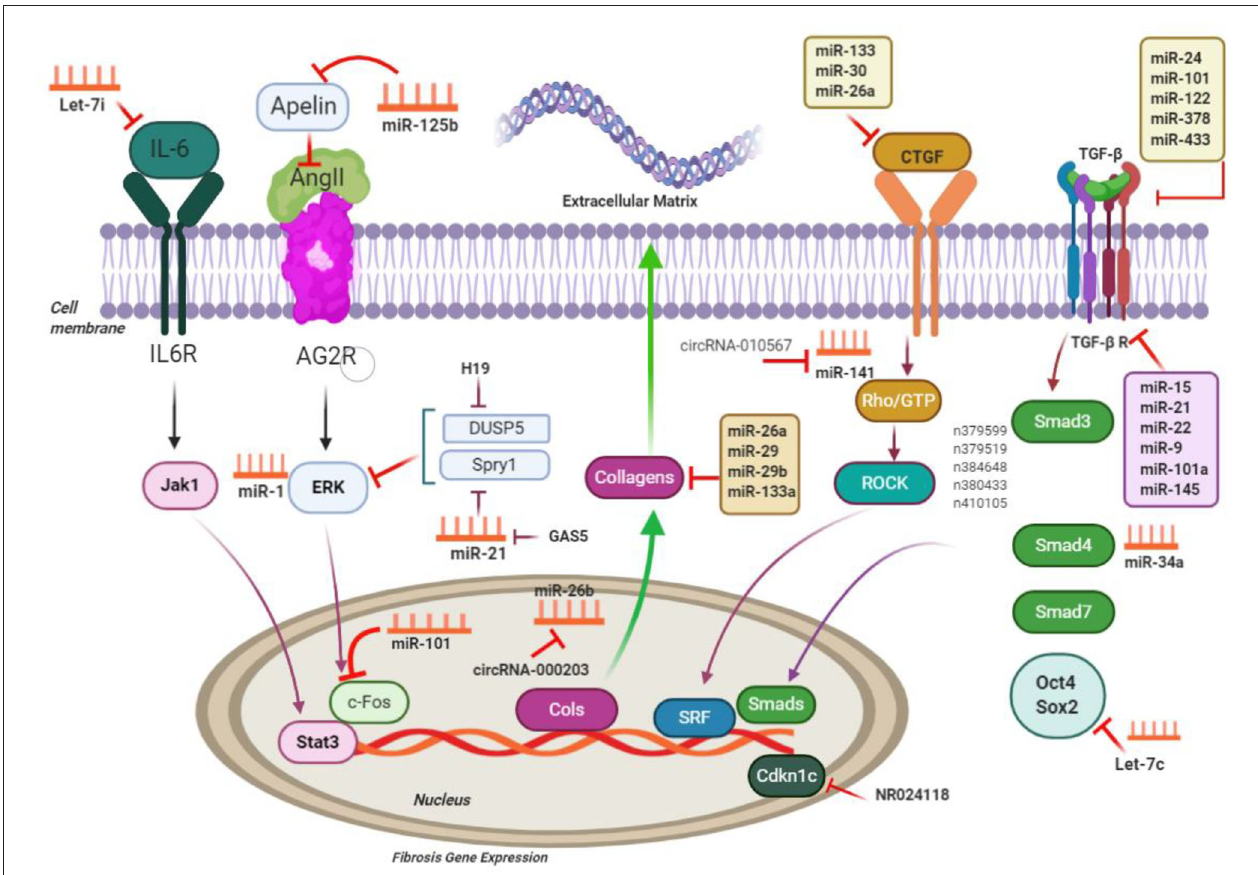
FIGURE 3 | ncRNAs engaged in the pathways of cardiac fibrosis; ncRNAs regulate processes related to cardiac fibrosis via targeting the main molecules mediating ECM gene transcription and performing TGF- β signaling; CTGF, connective tissue growth factor; Rho-GTP, Rho-GTPase-stimulating protein; ROCK, Rho related coiled-coil comprising protein kinase; SRF, serum response factor; MMP, matrix metalloproteinases; IL6, interleukin-6; Jak1, Janus kinase 1; Stat3, signal transducers and activators of transcription 3; c-Fos, FBJ murine osteosarcoma viral oncogene homolog; Spry1, sprouty homolog 1; ERK extracellular signal–regulated kinases; DUSP5, dual-specificity phosphatase 5. This figure was adapted from Chen et al. ( 49).